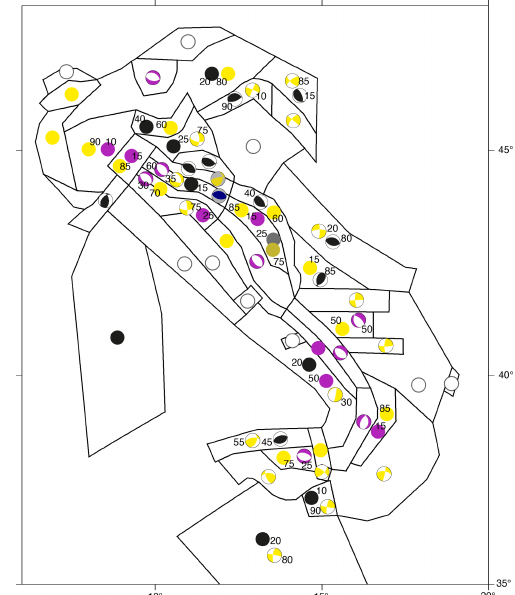
Figure 4. Expected style of faulting for each area source (modified from Pondrelli et al., 2020). Plain circles represent random seismic sources. White circles represent 100% random, while black, pur- ple and yellow circles correspond to reverse, normal and strike-slip random sources, respectively. Colours for cumulative focal mech- anisms follow the same criteria. Focal mechanisms with a grey background or plain circles with darker colours are the sources for deeper layers. Black numbers are the percentages of contribution to the final sources when their sum is the expected style of